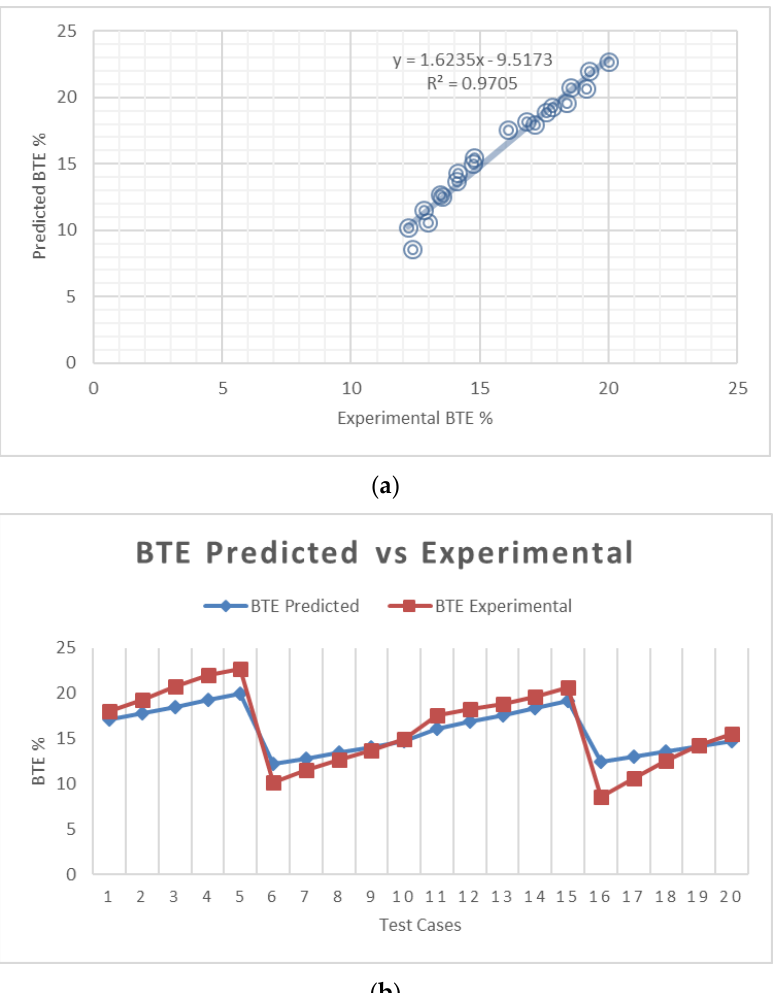
Figure 7. ( a ) Depiction of predicted and experimentally obtained BTE values taken for 20 test cases; ( b ) Regression coefficient for the values predicted using ANN Vs experimental.